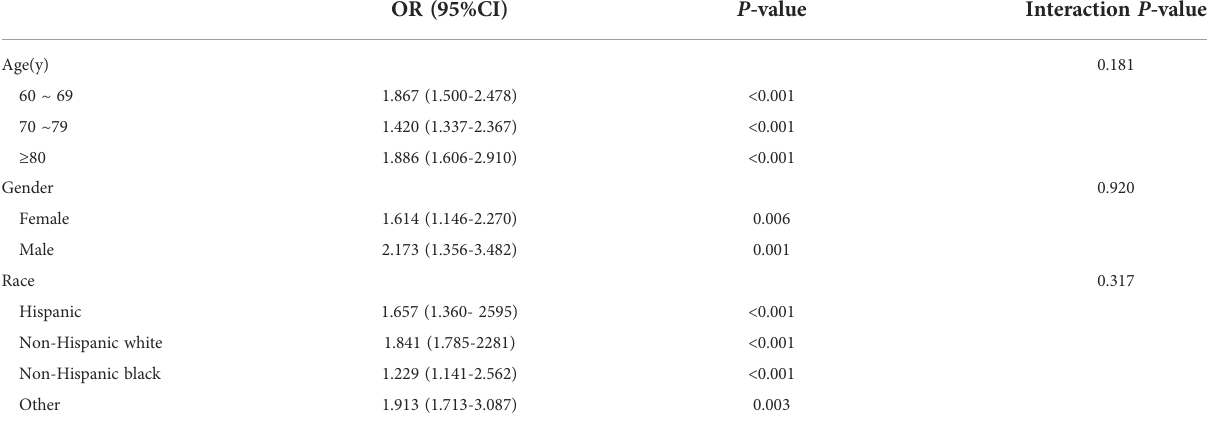
TABLE 3 Subgroup logistic regression analysis for the association between Low-GNRI and